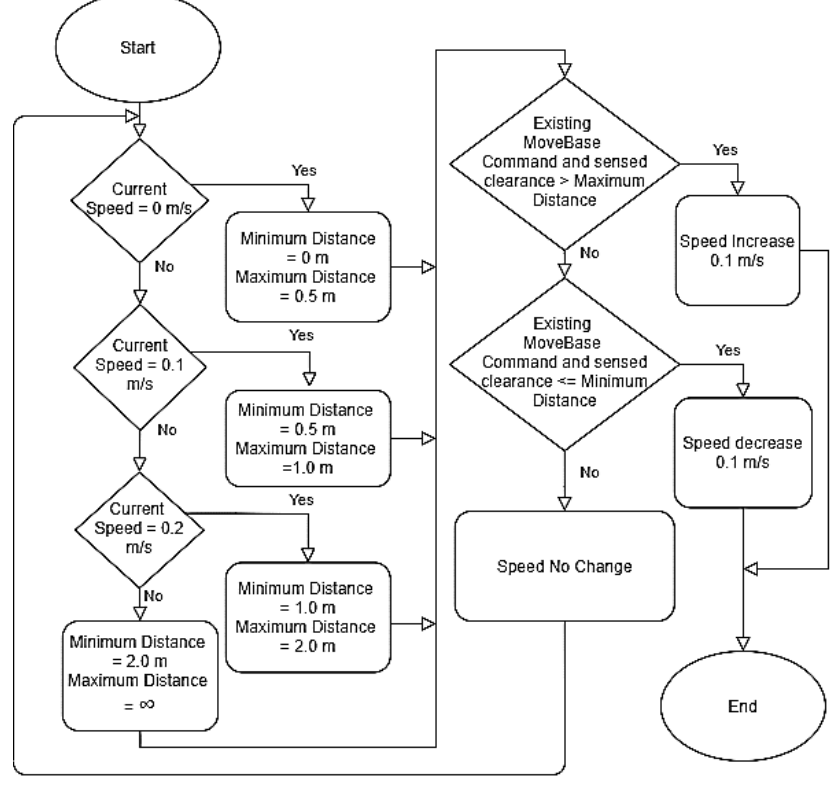
Figure 9. Cruise state algorithm.